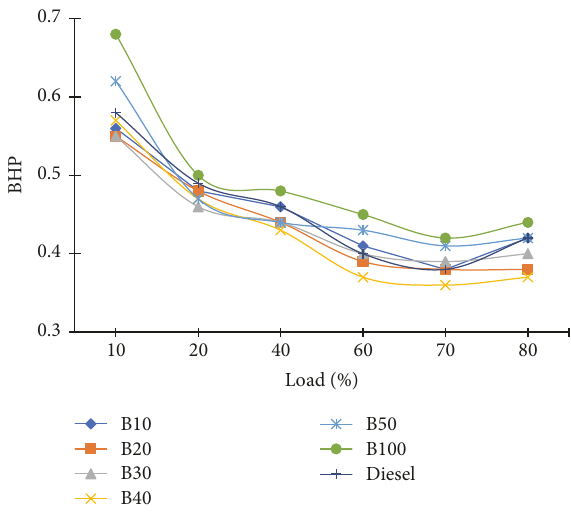
Figure 11: Beak horsepower for different